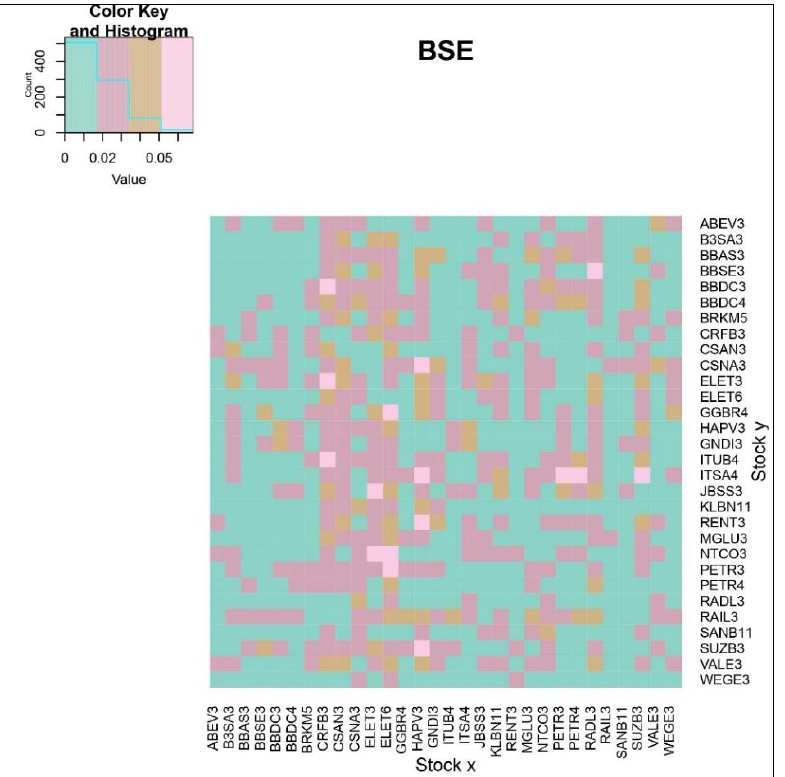
Figure 2. The information flow (effective transfer entropy) from stock y to stock x, for the top companies (by market capitalization) in the BSE market, after the COVID-19